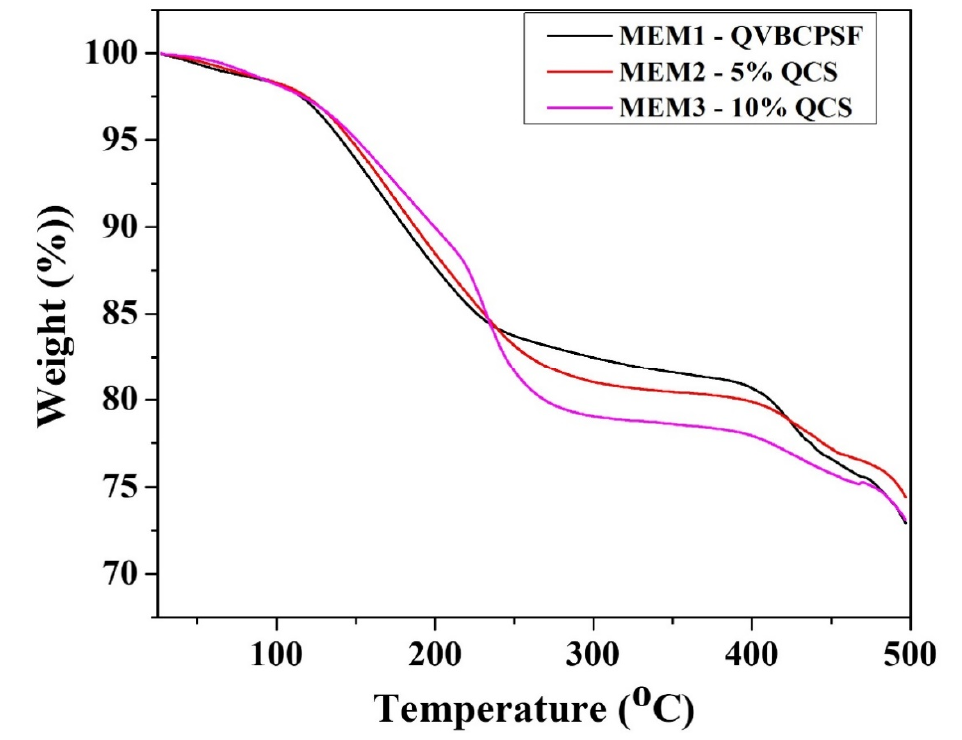
Figure 8. TGA curves of different ratio membrane.